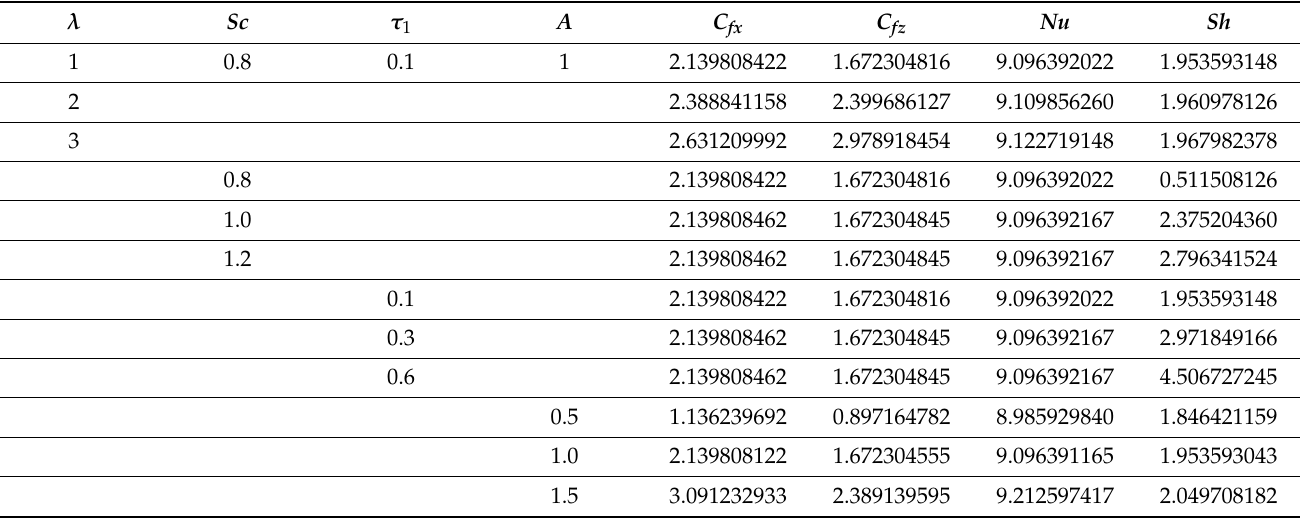
Table 8. Computational values of C fx , C fz , Nu and Sh for various dimensionless constraints in the presence of nanoparticle aggregation with φ =